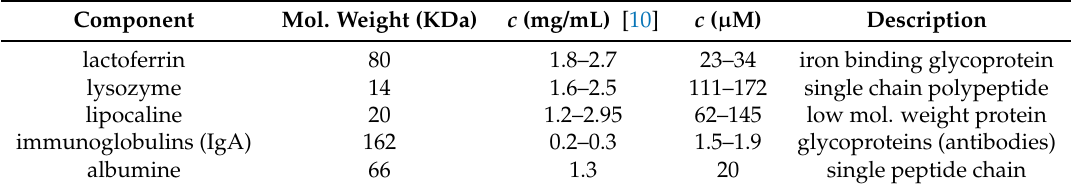
Table 3. Main components of human